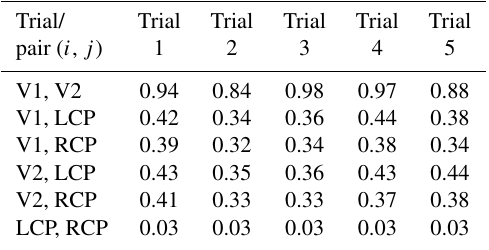
Figure 9. Correlation coefficients for different antennas and mea- surement trial 4. Table 8. Mean values of the power correlation coefficient over fre- quency for different antenna pairs.